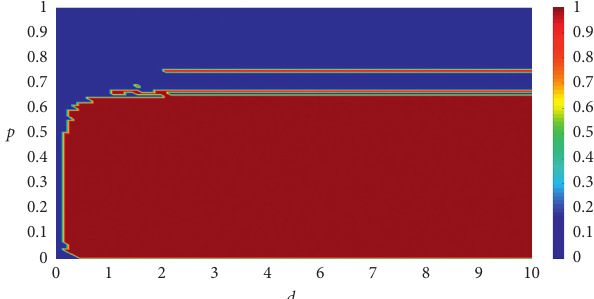
Figure 16: The instability region is related to the parameters d p , where the red region is the instability